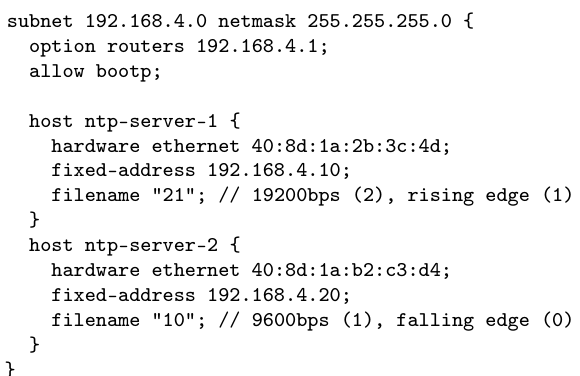
Table 4. Packet RAM memory map.